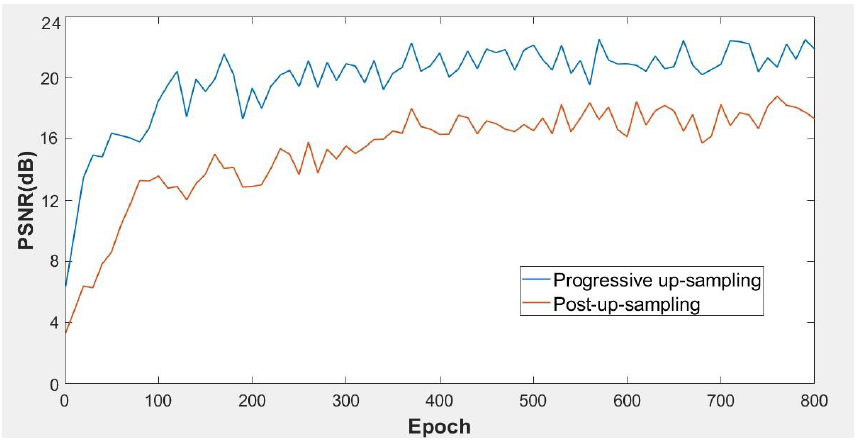
Figure 22. Comparison of the convergence of progressive upsampling and post-upsampling frame- work at × 8 scale.